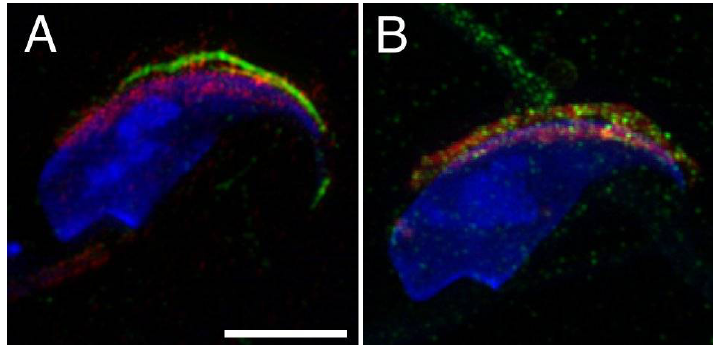
Figure 2. Precise localization of CD9 within the inner and outer acrosomal membranes depicted by structure illumination microscopy (SIM) in mouse epididymal sperm head. ( A ) SIM data confirm localization of CD81 (green) in plasma membrane of apical acrosome area and localization of CD9 in acrosomal membrane and absence of their mutual contact in epididymal sperm; ( B ) CD46 (red) was used as marker for confirmation of presence of CD9 (red) in both outer and inner acrosomal membranes. DAPI (blue). Scale bar represents 5 μm.